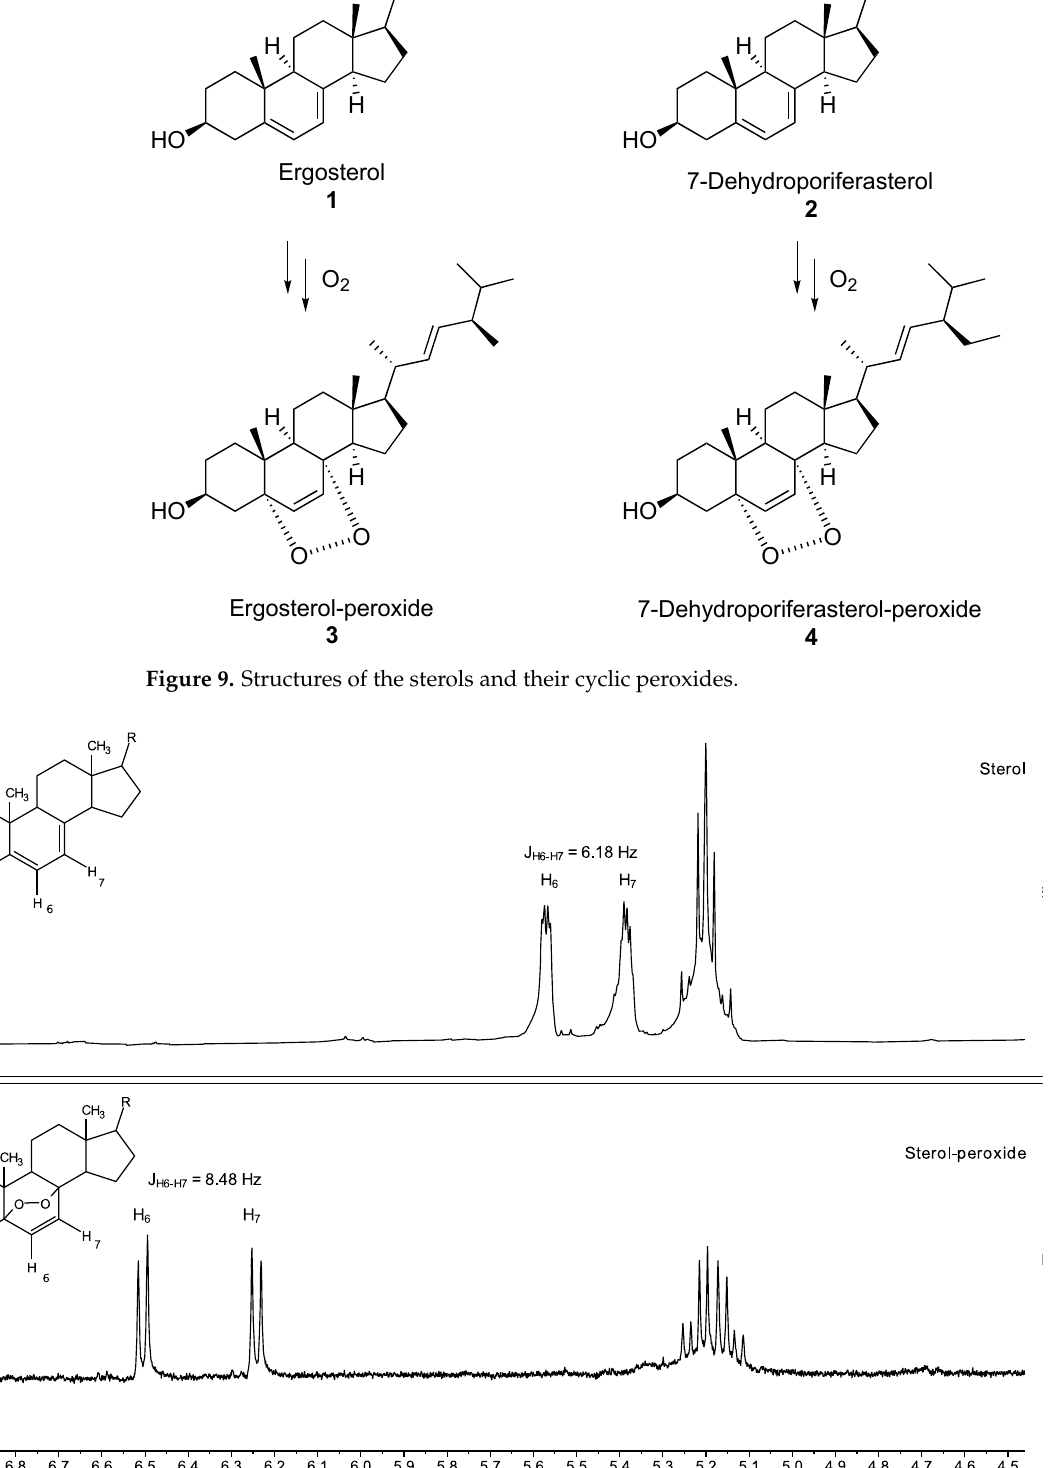
Figure 10. Key 1 H ‐ NMR signals of protons H6 and H7 in ergosterol (top panel) and its peroxidized Figure 10. Key 1 H-NMR signals of protons H6 and H7 in ergosterol (top panel) and its peroxidized analogue (bottom panel). analogue (bottom